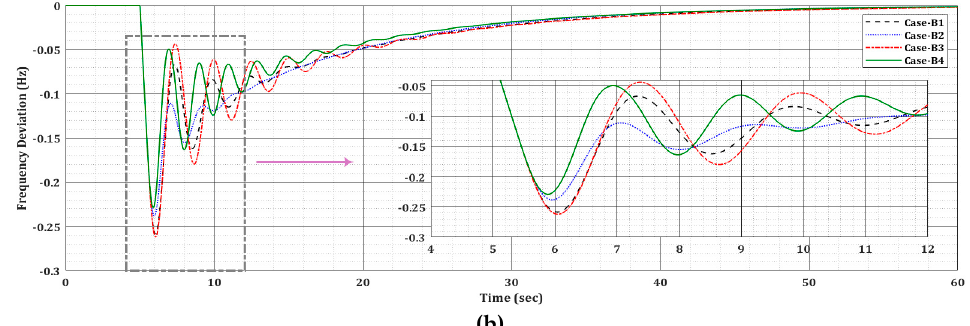
Figure 5. Frequency response for various configuration of the test system under load disturbance ( a ) frequency deviation for single-machine cases (A1-A3); ( b ) frequency deviation for multi-machine cases (B1-B4).